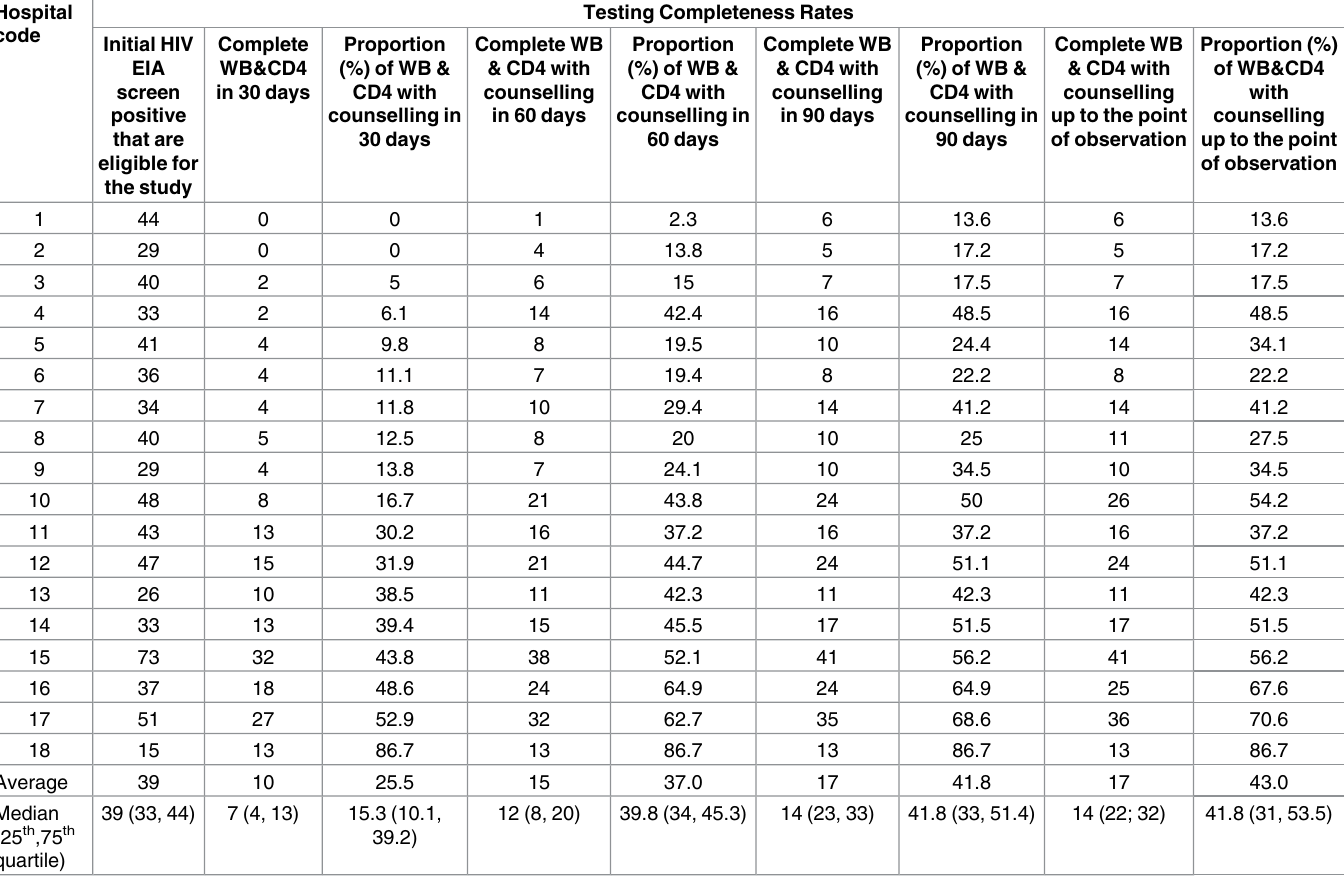
Table 1. The number of newly screened HIV positive cases and the testing completeness proportions in 18 county general hospitals in Guangxi between January 1 and June 30,